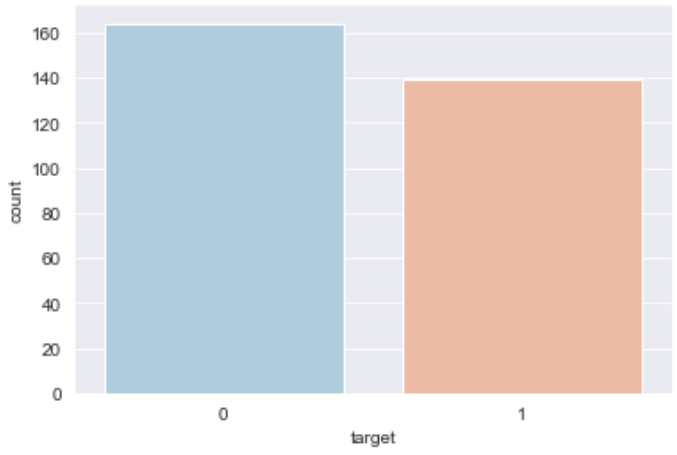
Figure 3. Count of each target